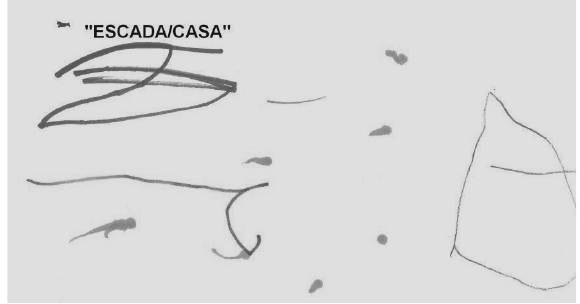
Figura 4. Desenho produzido pela criança de 3 anos, nomeado como casa e